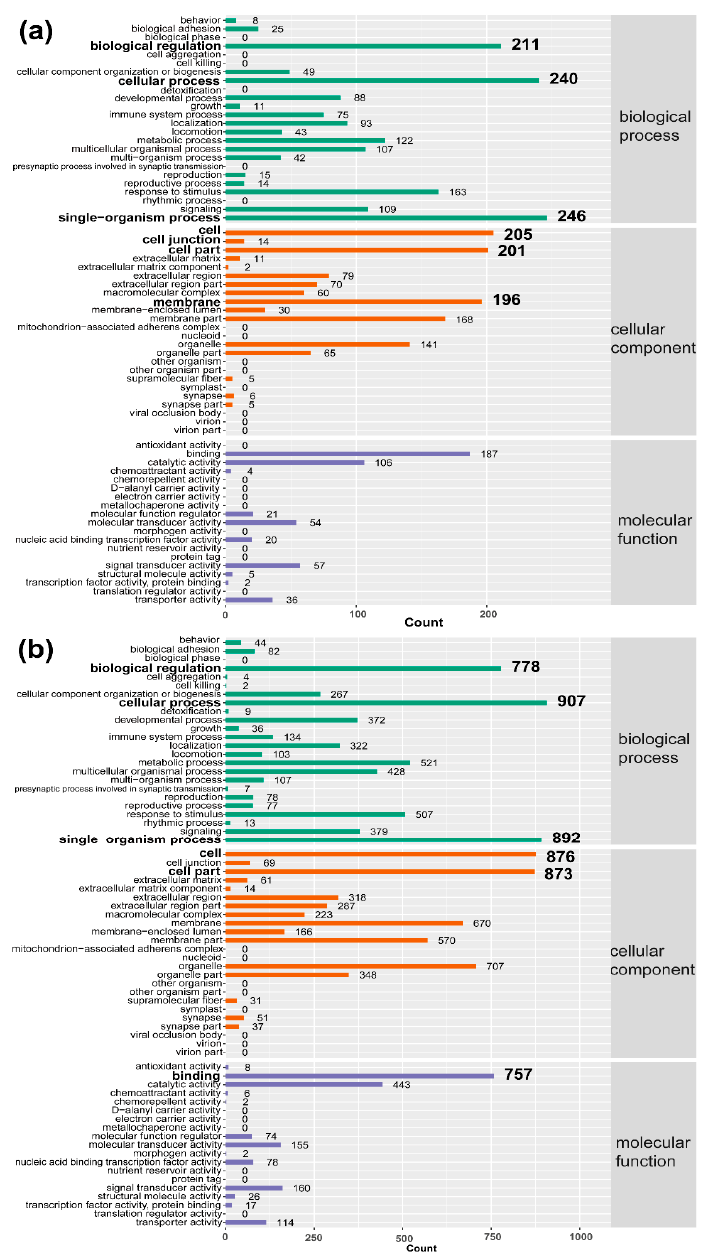
Figure 4. Gene Ontology enrichment of differentially expressed genes ( a ): 12 h post ‐ infection (hpi); ( b ): 24 h post ‐ infection 24 hpi.